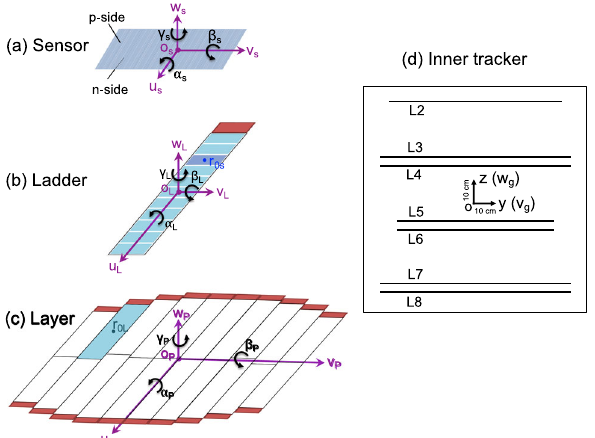
Fig. 3 The components and coordinate systems of a a sensor, b a lad- der, c a layer, and d the inner tracker. The inner tracker coordinate system is also the global coordinate